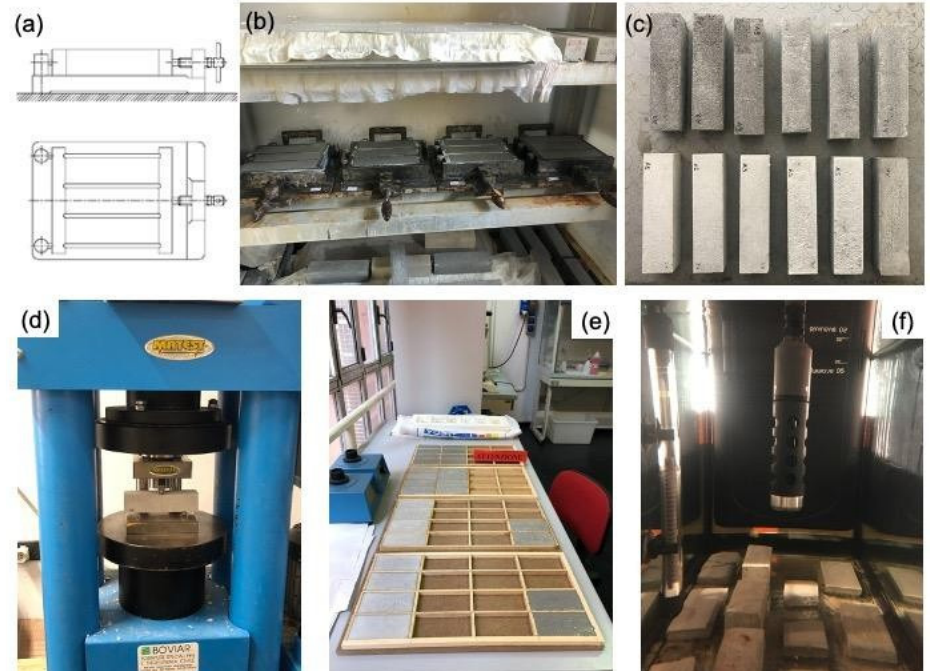
Figure 1. ( a ) Steel mold scheme consisting of three horizontal compartments for prismatic specimens’ preparation (16 × 4 × 4 cm); ( b ) cabin storage for curing specimens; ( c ) specimens after 28 days of curing time; ( d ) compressive strength testing machine; ( e ) wood mold for specimen preparation (10 × 8 × 0.8 cm); ( f ) rectangular glass tank for lab experimentation.